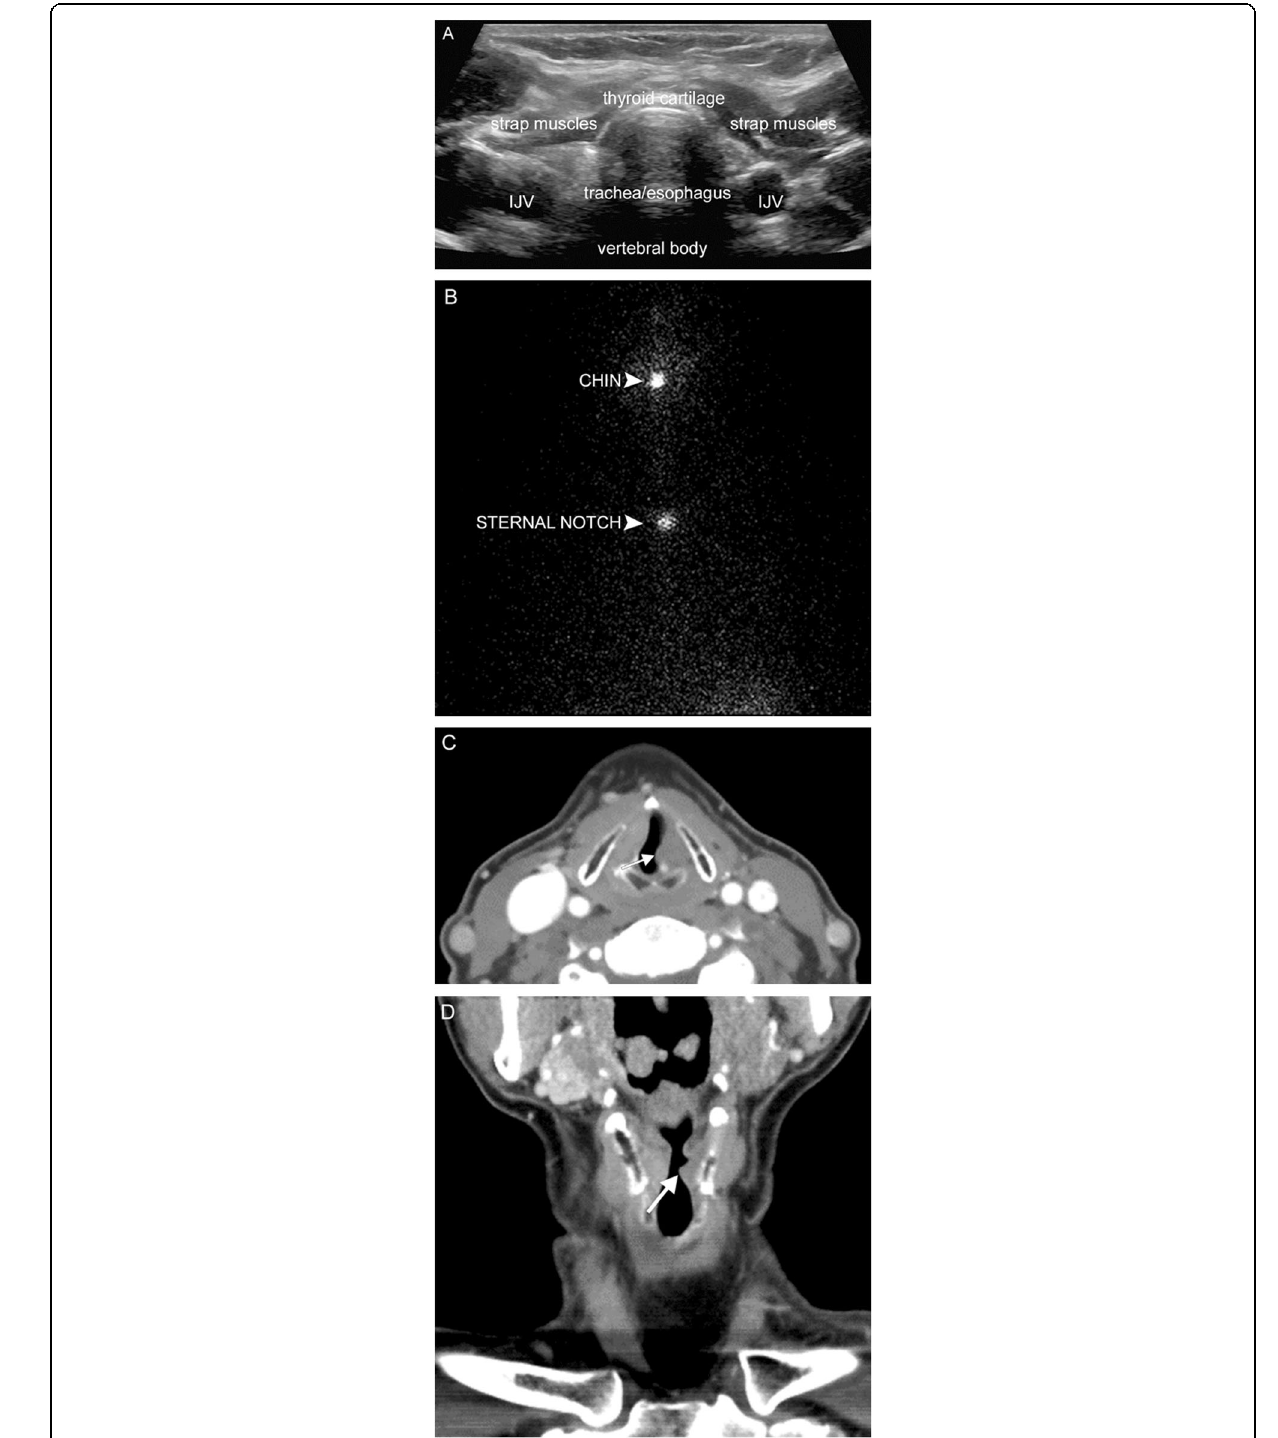
Fig. 23 Thyroidectomy. A 63-year-old woman status post total thyroidectomy and radioablation for papillary thyroid carcinoma. Neck ultrasound ( a ), I-131 whole body scintigraphy ( b ), and axial/coronal post-contrast CT images ( c , d ) demonstrate no evidence for residual thyroid tissue in the thyroid bed. In addition, the left vocal fold is medialized (arrow) with dilatation of the left laryngeal ventricle, suggesting vocal cord paralysis due to iatrogenic